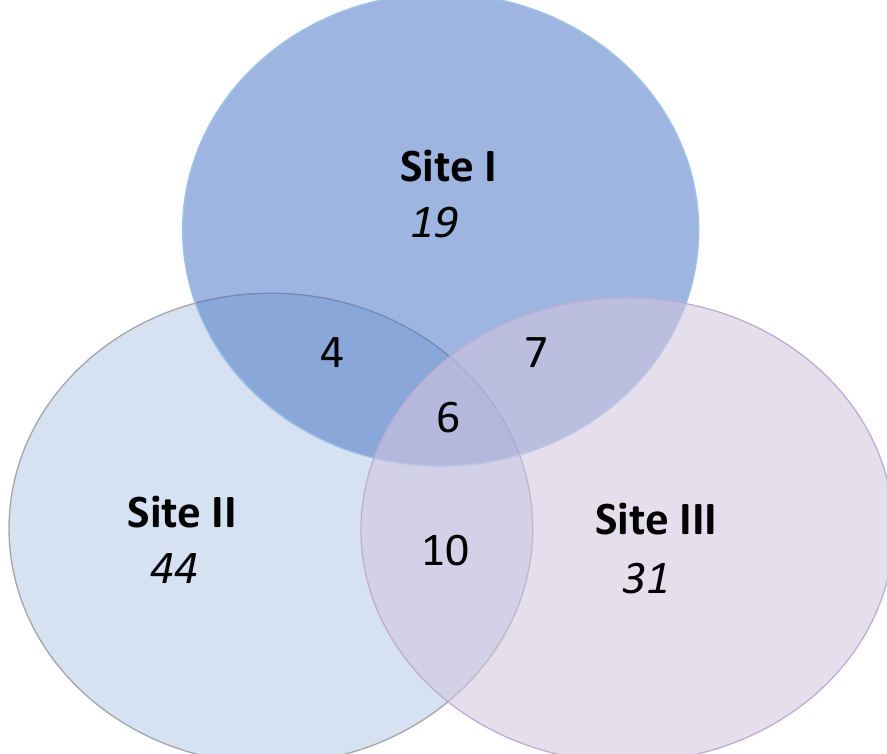
Figure 4. Venn diagram displaying the number of fungal endophyte morphotaxa detected in the samples from elm trees growing at the three sites where vaccinations were ongoing at the time of sampling (Site I), where vaccinations had ceased (Site II) and where trees had not been vaccinated (Site III). Numbers in the overlapping regions indicate shared morphotaxa between the groups. Numbers in the non-overlapping regions indicate unique morphotaxa for the